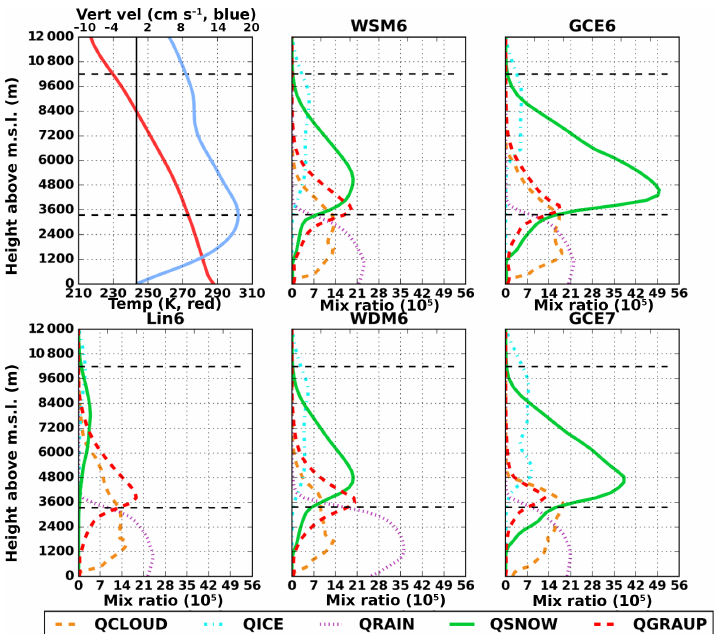
Figure 4. Domain 4 averaged (1.167km grid spacing) mixing ratios (kgkg − 1 ) , temperature (K), and vertical velocity (cms − 1 ) at the same time as Fig. 2. The black dashed lines denote the height above mean sea level (MSL) where the air temperature is 0 or − 40 ◦ C. The upper-left panel shows composited and model-averaged profiles of temperature (red line) and vertical velocity (blue). Mixing ratio species abbreviations are QCLOUD (cloud water), QGRAUP (graupel), QICE (cloud ice), QRAIN (rain), QSNOW (snow), and QHAIL (hail).